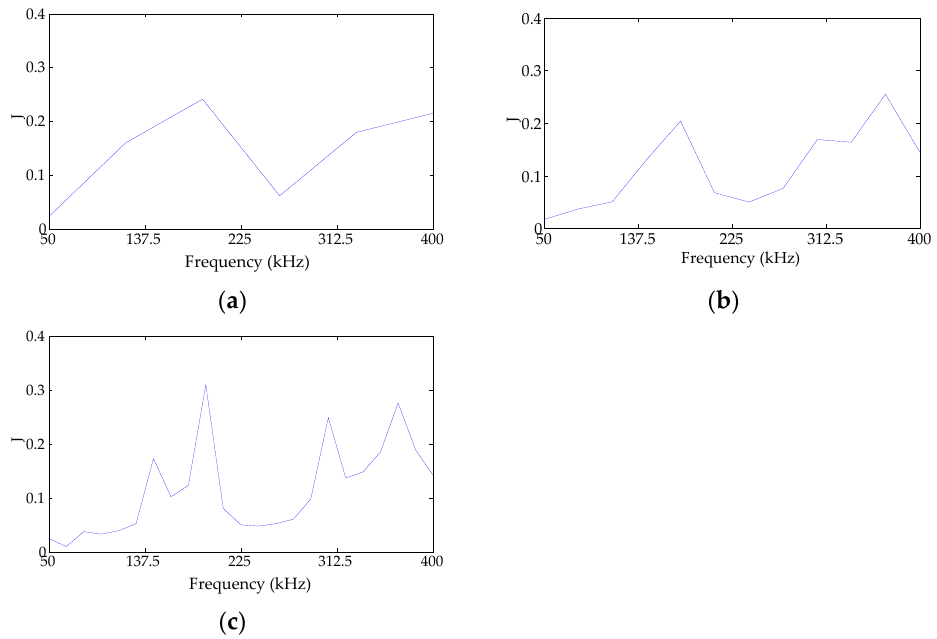
Figure 12. Feature scattering index J for adopting workpiece AE signals: ( a ) bandwidth size 64 KHz; ( b ) bandwidth size 32 KHz; ( c ) bandwidth size 16 KHz.